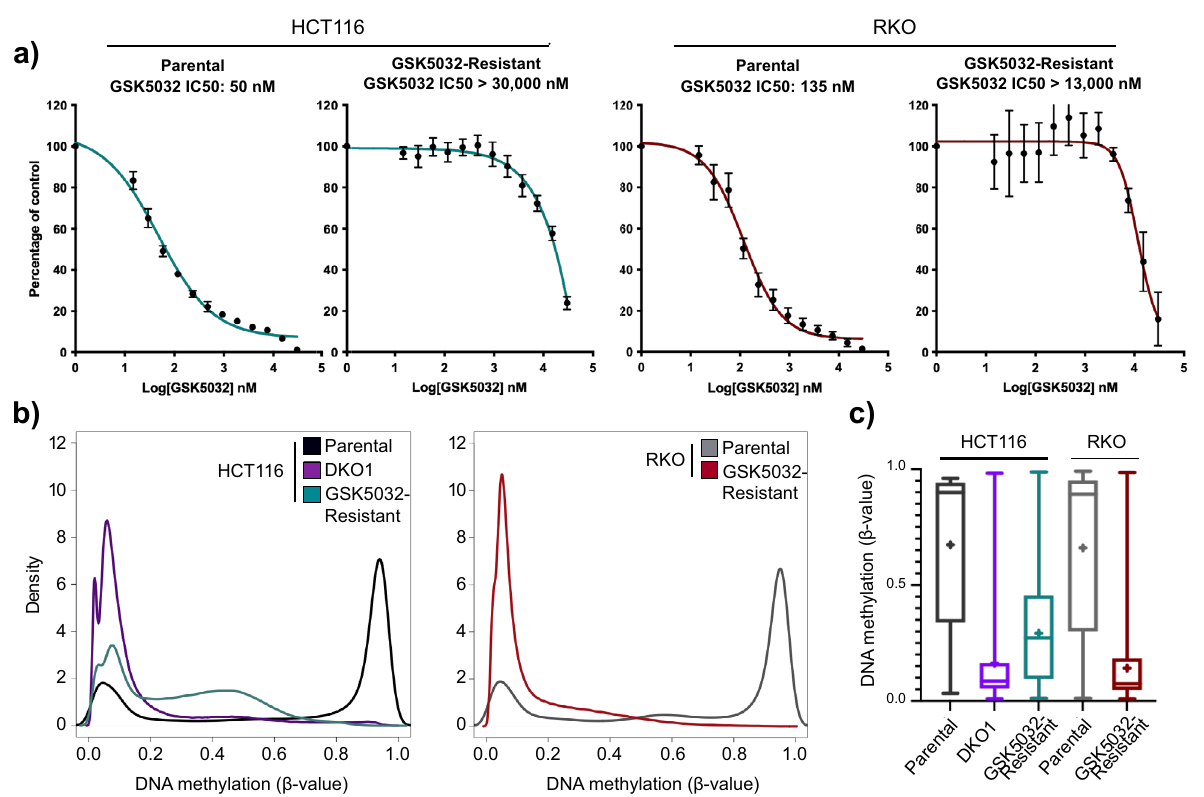
Fig. 1 HCT116 and RKO GSK5032-resistant cells are globally demethylated. a Dose dependency curves showing that HCT116 and RKO cells long term treated with high doses of GSK5032 become resistant. Each point represents a percentage of surviving cells compared to cells treated with a vehicle control ( n = 5 for HCT116 parental, n = 7 for HCT116 GSK5032-resistant, n = 3 for RKO parental, and n = 3 for RKO GSK5032-resistant). b DNA methylation density curves showing the distribution of the β -values on the In fi nium EPIC methylation array ( n = 627,029 probes). Probes with detection pval > 0.05 in any sample were removed from the analysis. β -values range from 0.0 to 1.0 where a β -value of 0.0 indicates completely unmethylated and a β -value of 1.0 indicates complete methylation. c Box plot of DNA methylation ( β -value) distribution of all EPIC array probes for each individual sample queried in ( b ). Center line, median; box limits, upper and lower quartiles; whiskers, 5 and 95% percentile; ‘ + ’ , mean; outliers removed for visualization purposes ( n = 627,029